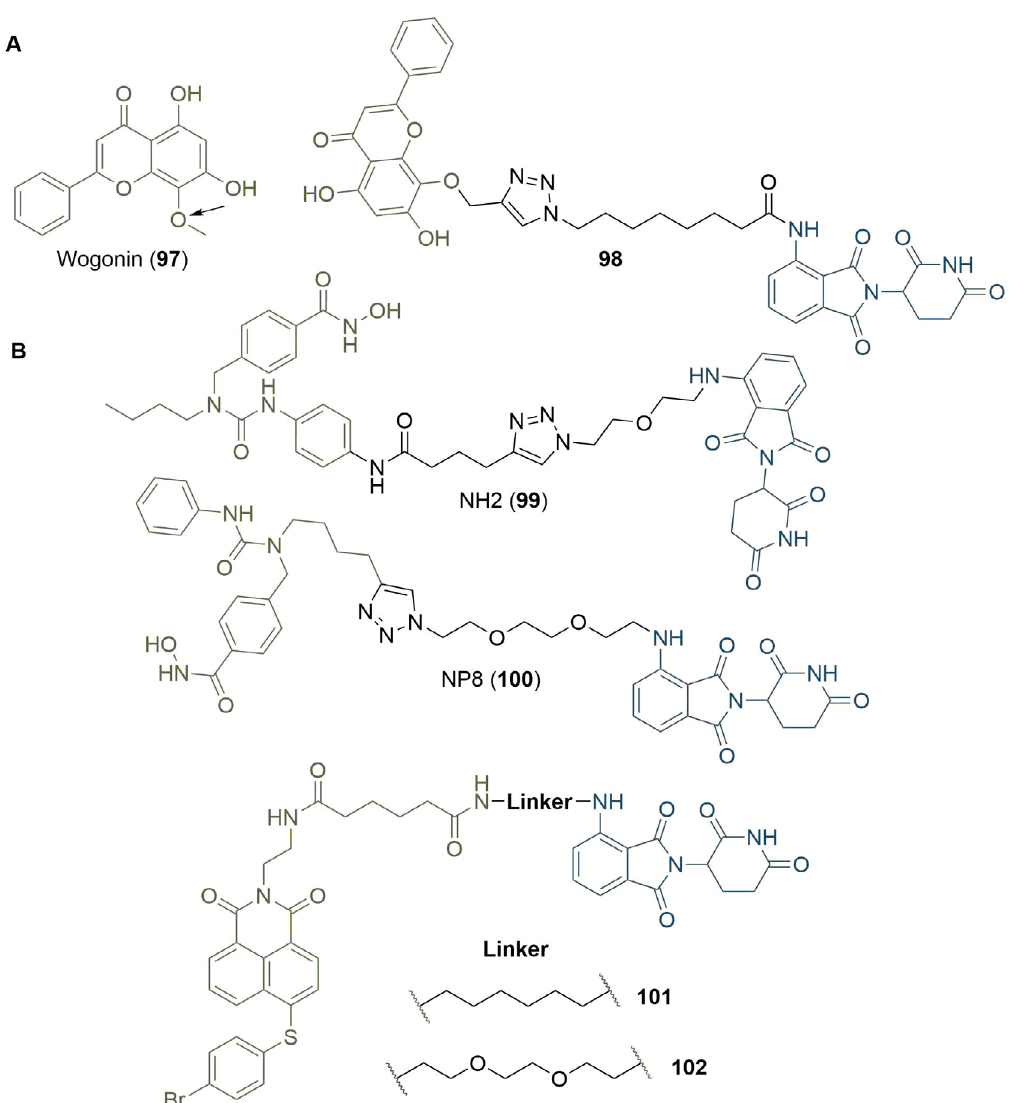
Figure 21. Use of computational docking to inform rational linker design. A. Docking pose of wogonin (97) was used to identify suitable conjugation vectors whilst retaining key binding interactions (site indicated by arrow), which was achieved in PROTAC 98; B. experimental SAR studies combined with computational docking was used to probe plausible TC ensembles formed by HDAC6 degraders 99 and 100, and suggested that each degrader employed a different set of amino acids to form distinct productive TCs. Similarly, modelling of the TC using a combination of docking and molecular dynamics was used to explain the orthogonal selectivities displayed by 101/102 towards